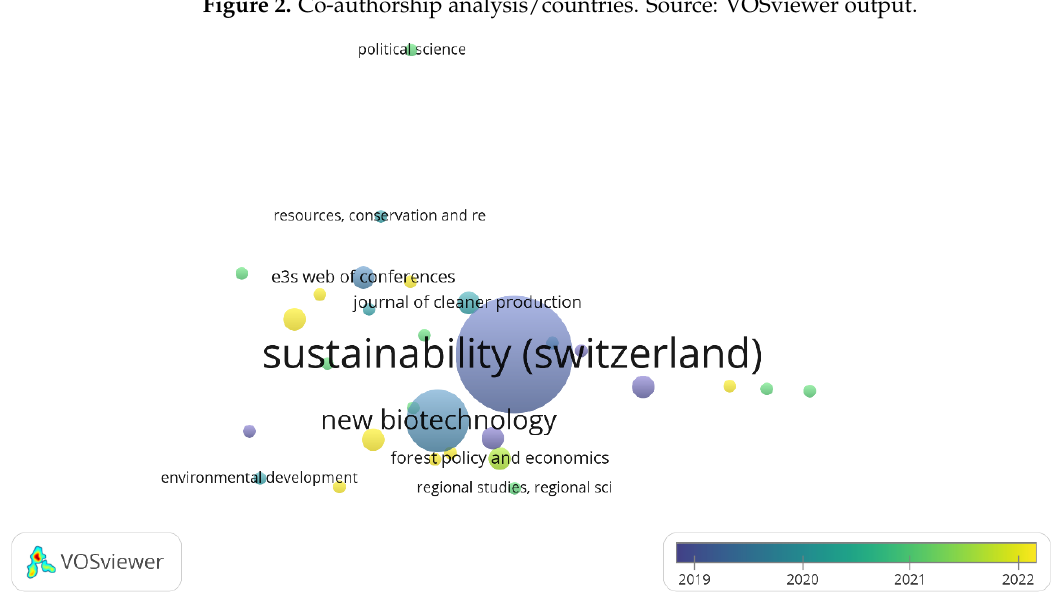
Figure 2. Co-authorship analysis/countries. Source: VOSviewer output.